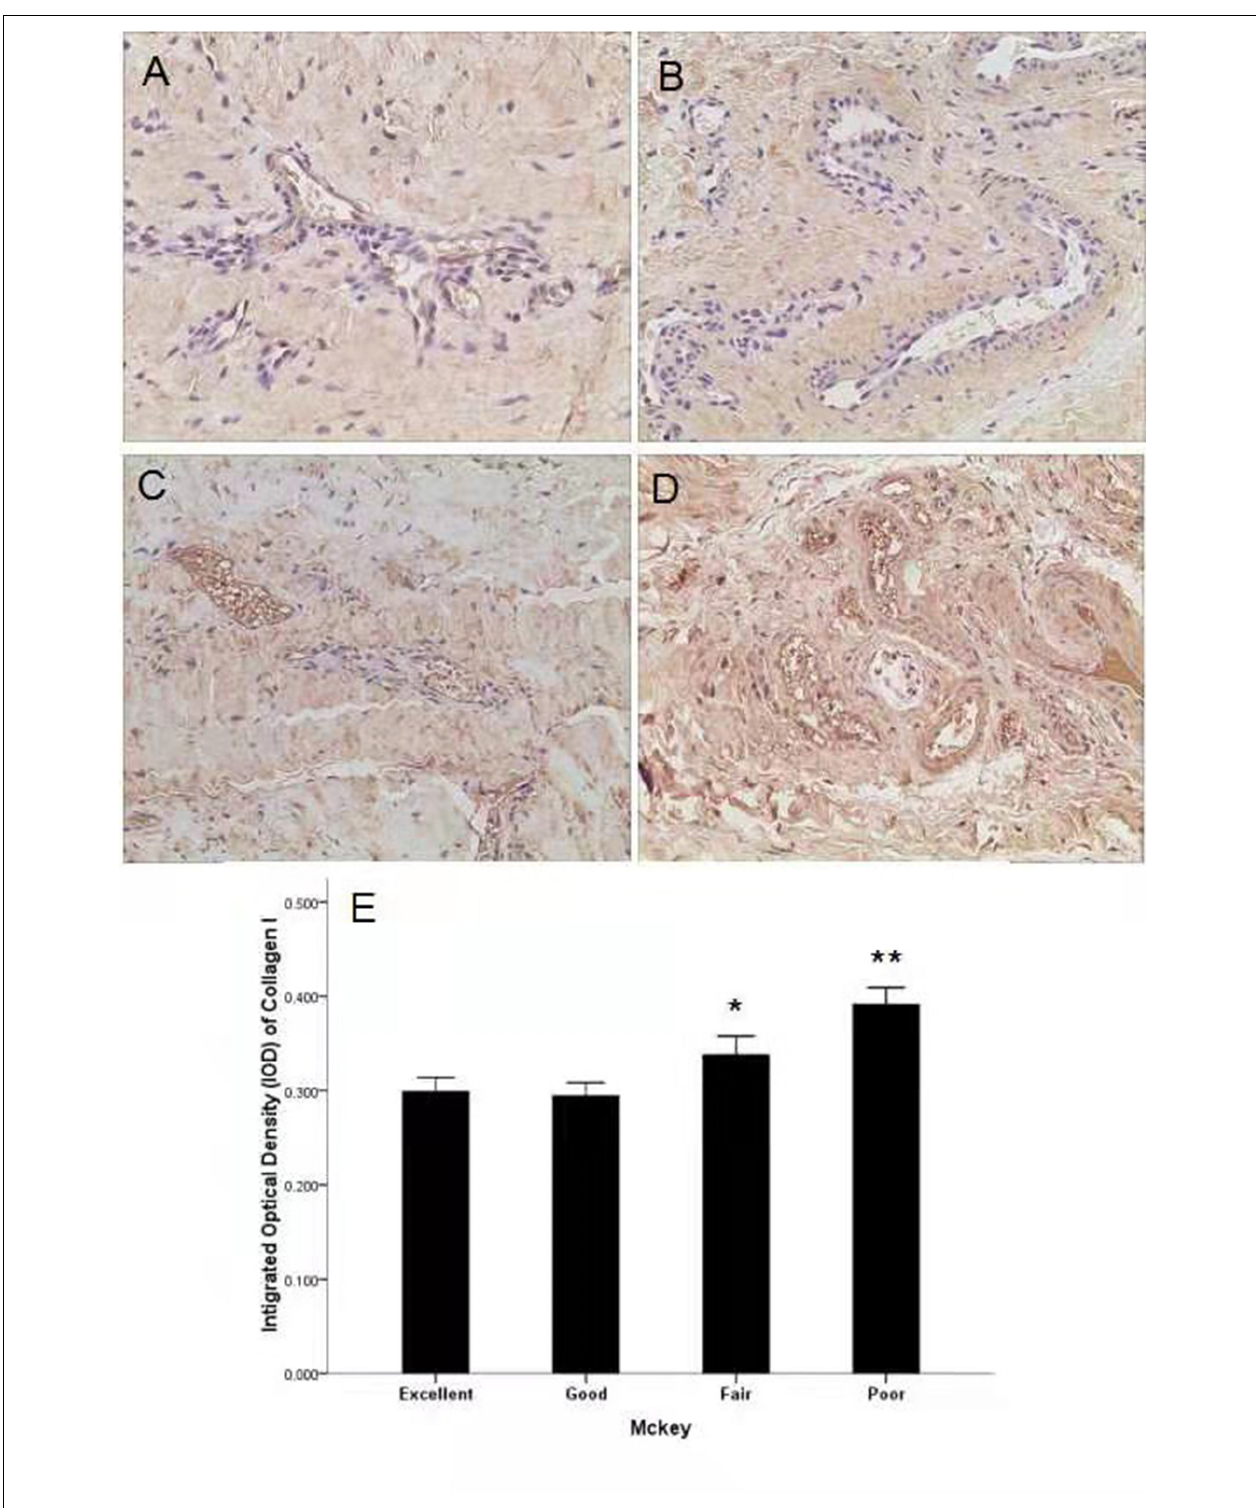
FIGURE 3 | Expression of collagen I in different groups according to the McKey score. (A) Representative image of an excellent-group DDH capsule. (B) Representative image of a good-group DDH capsule. (C) Representative image of a fair-group DDH capsule. (D) Representative image of a poor-group DDH capsule and higher expression of collagen I was observed. (E) Quantification of collagen I immunohistochemistry results by measurement of the IOD in different groups. * P < 0.05; ** P < 0.001; Magnification: 10 × 40.